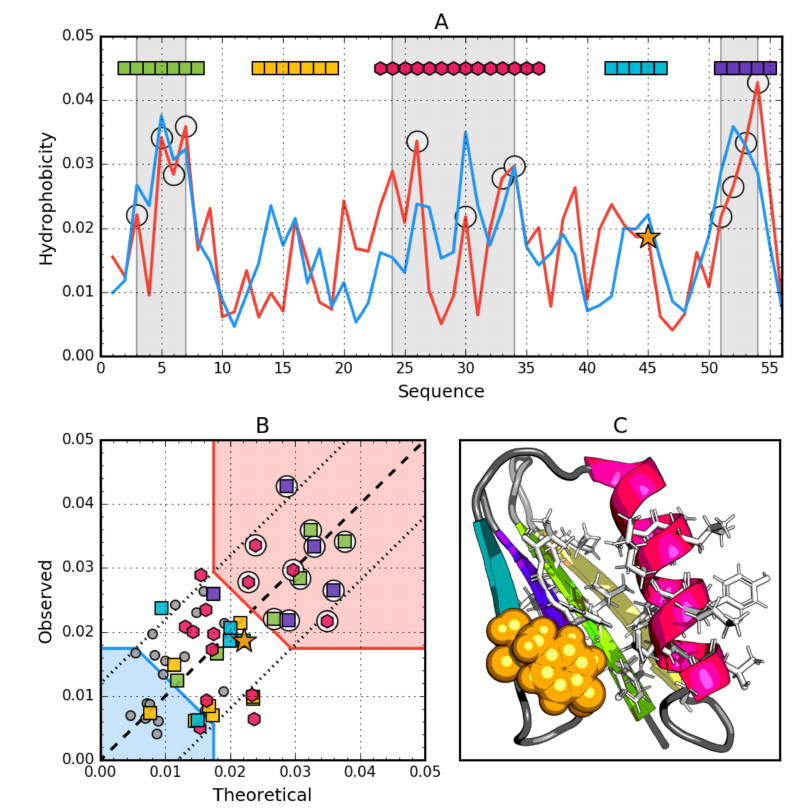
Figure 3. Hydrophobic properties of Gb98 (2LHD). ( A ) theoretical—blue and observed—red hydrophobicity density profiles. Markers at the top denote individually colored elements of